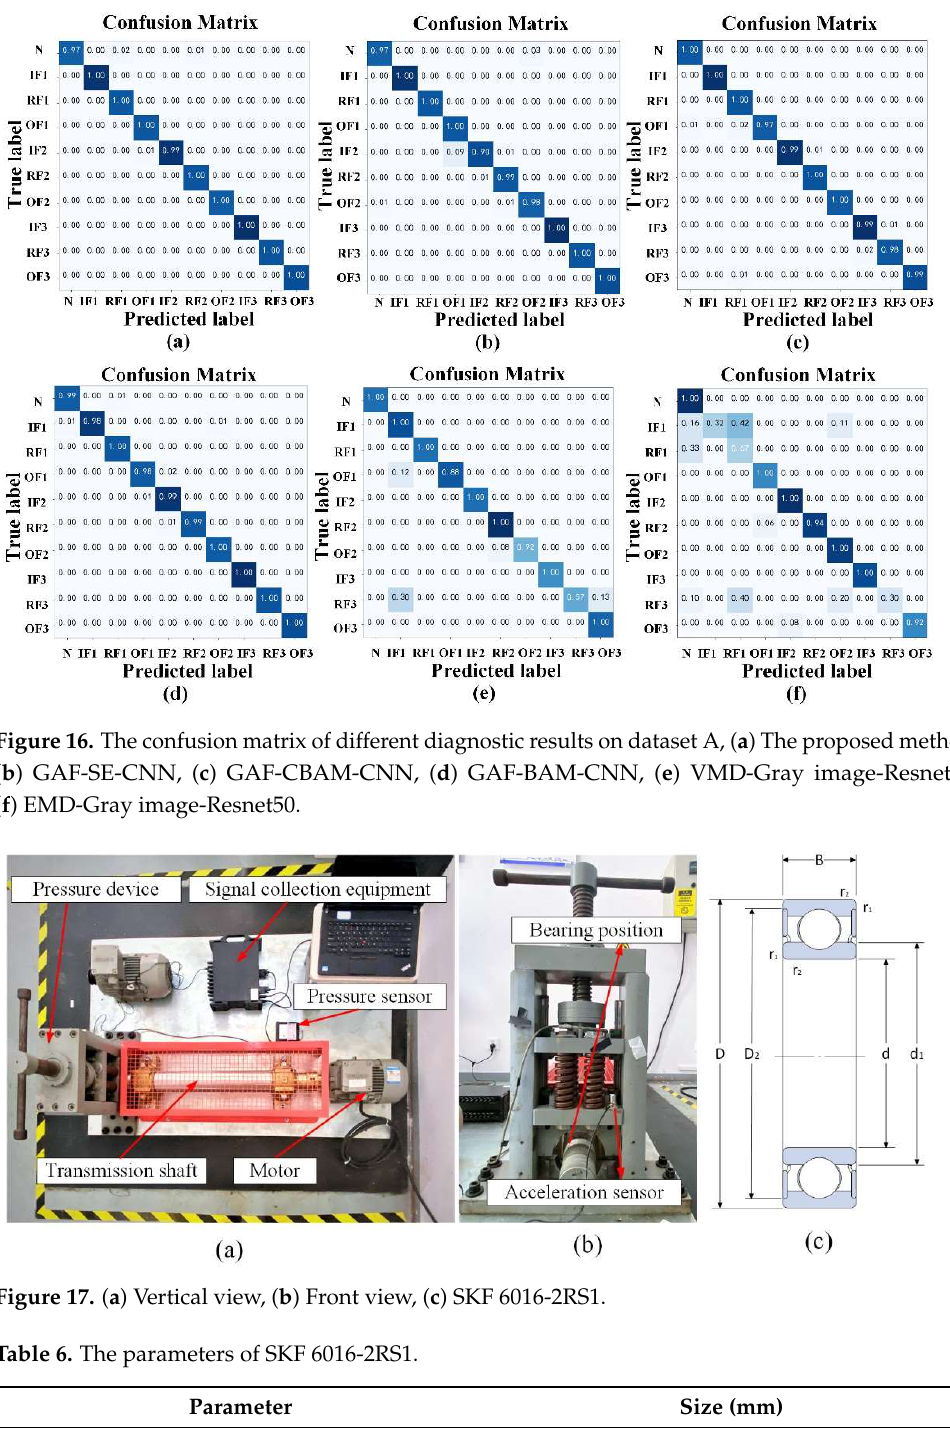
Figure 15. Visualization of different diagnostic results on dataset A, ( a ) The proposed method, ( b ) GAF-SE-CNN, ( c ) GAF-CBAM-CNN, ( d ) GAF-BAM-CNN, ( e ) VMD-Gray image-Resnet50, ( f ) EMD-Gray image-Resnet50.